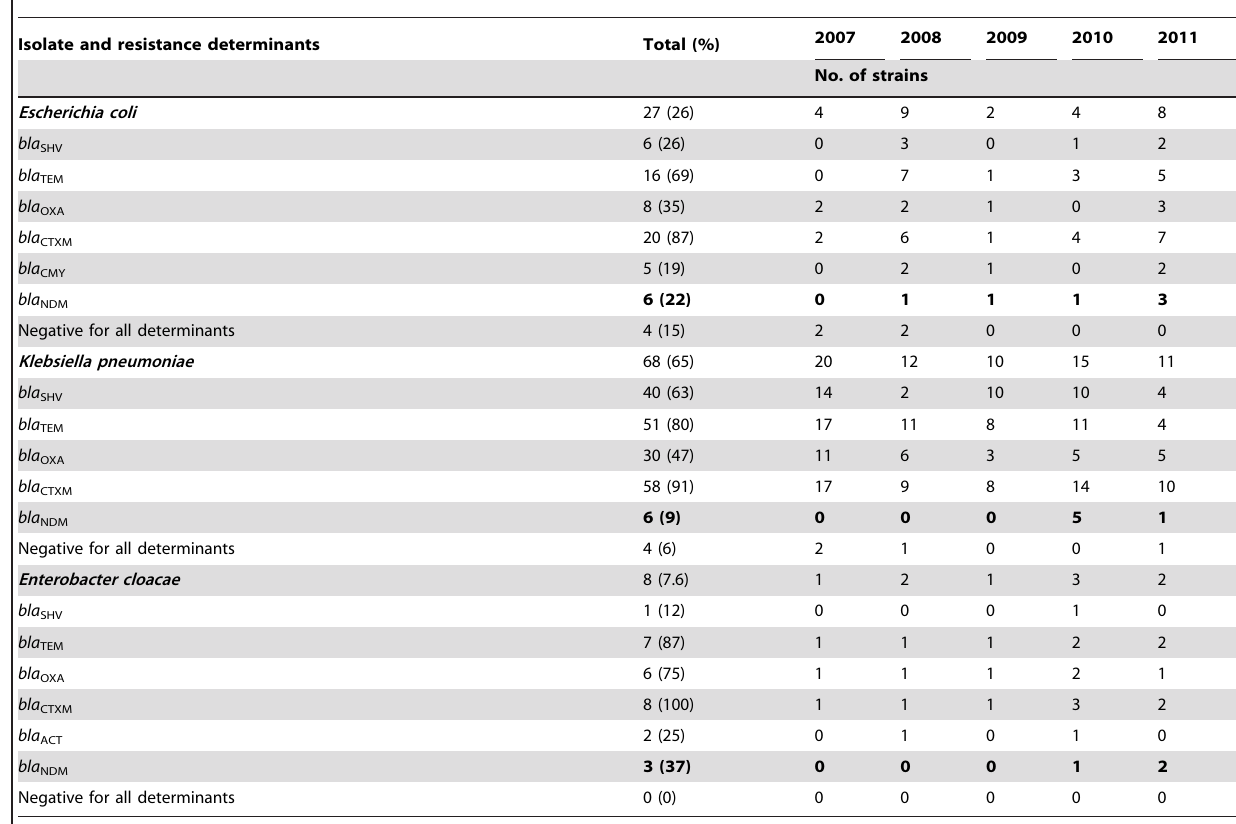
Table 2. Distribution of resistance determinants among Enterobacteriaceae isolates (2007–2011).